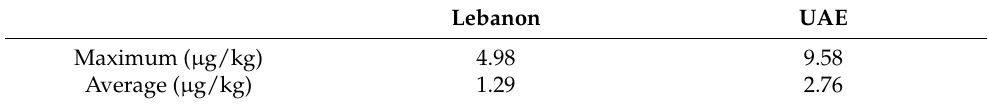
Table 1. Mean, range, and average OTA in rice collected from Lebanon and UAE.